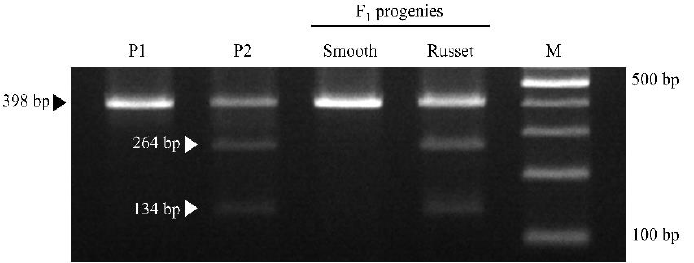
Figure 2. Application result of CBp08ca01 in ‘Whangkeumbae’ (P1), ‘Minibae’ (P2), smooth F 1 , and russet F 1 . The F 1 DNA samples consisted of 20 individuals representing smooth and russet types. Black and white triangles indicate DNA fragments generated from smooth and russet pears, respectively. M, 100 bp ladder marker.